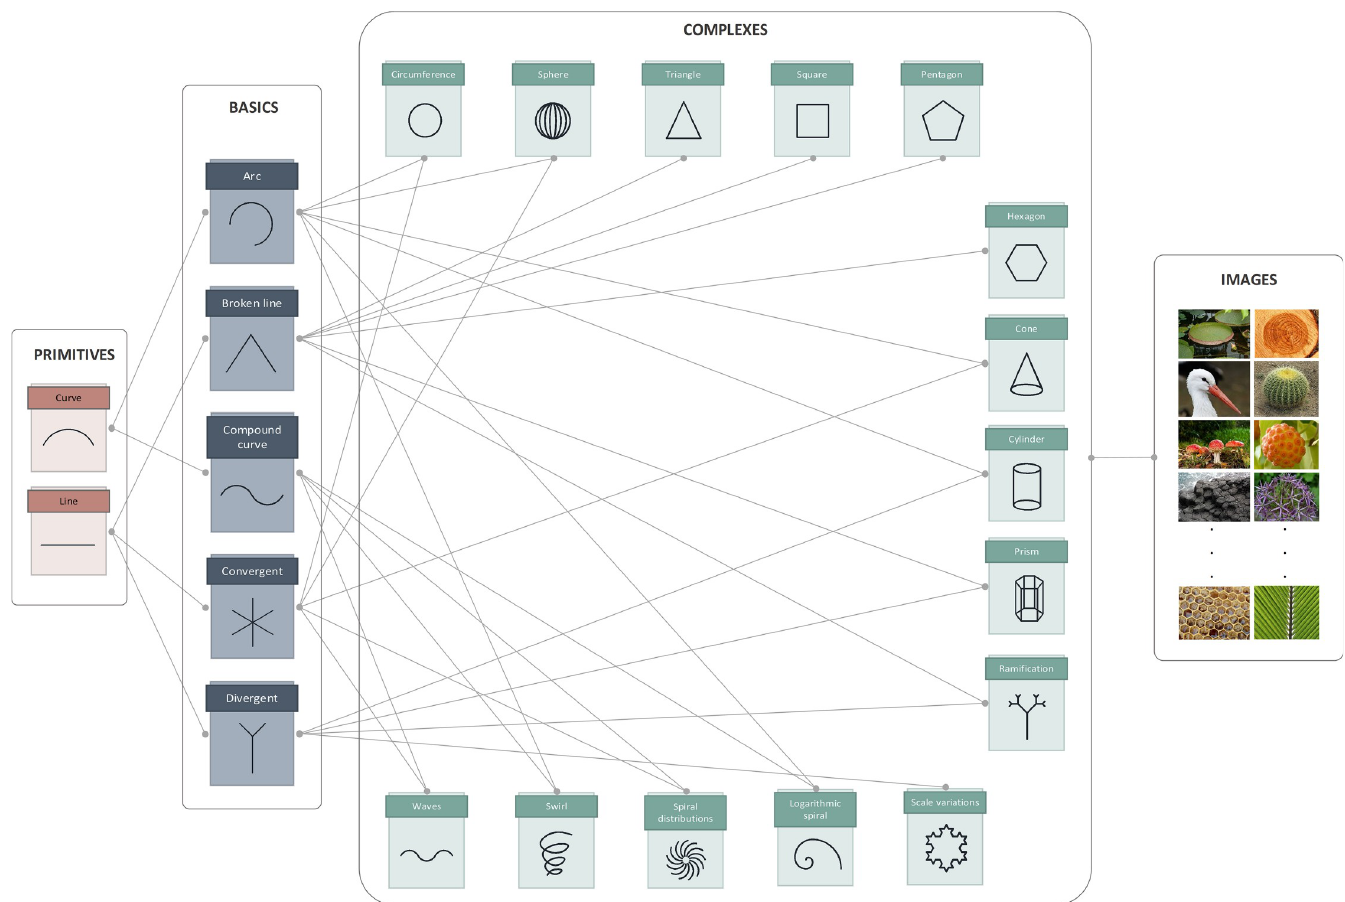
Fig 2. Relations between the symbols at each